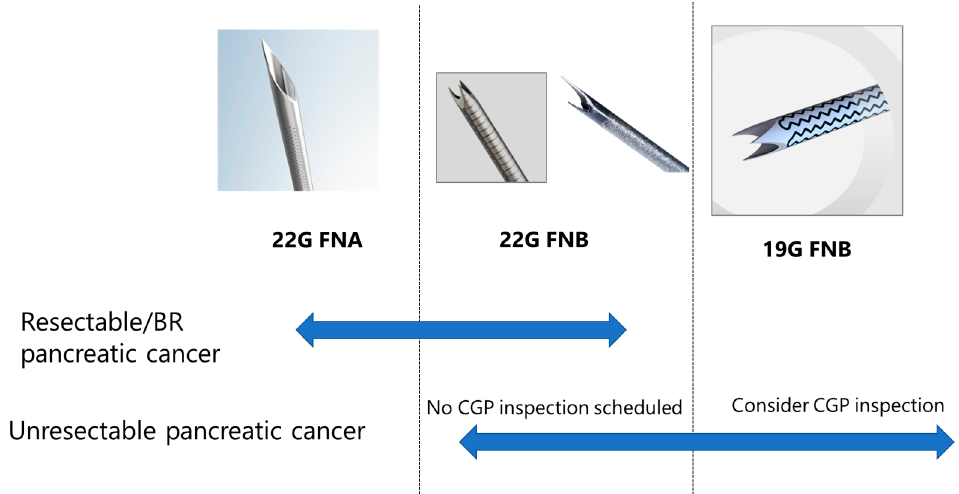
Figure 2. EUS-TA recommendations. For resectable/borderline resectable (BR) pancreatic cancer, 22-